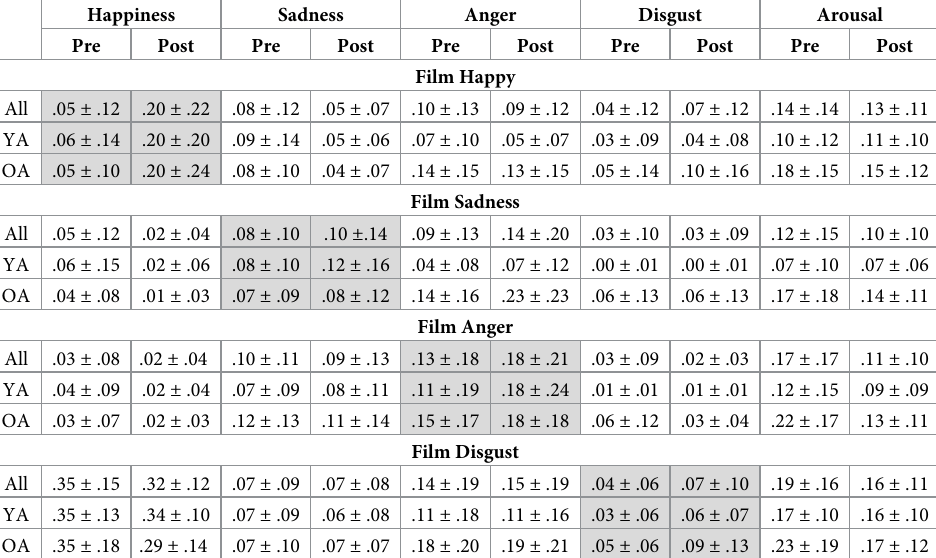
OA = older adults, YA = young adults; target emotions for each video in